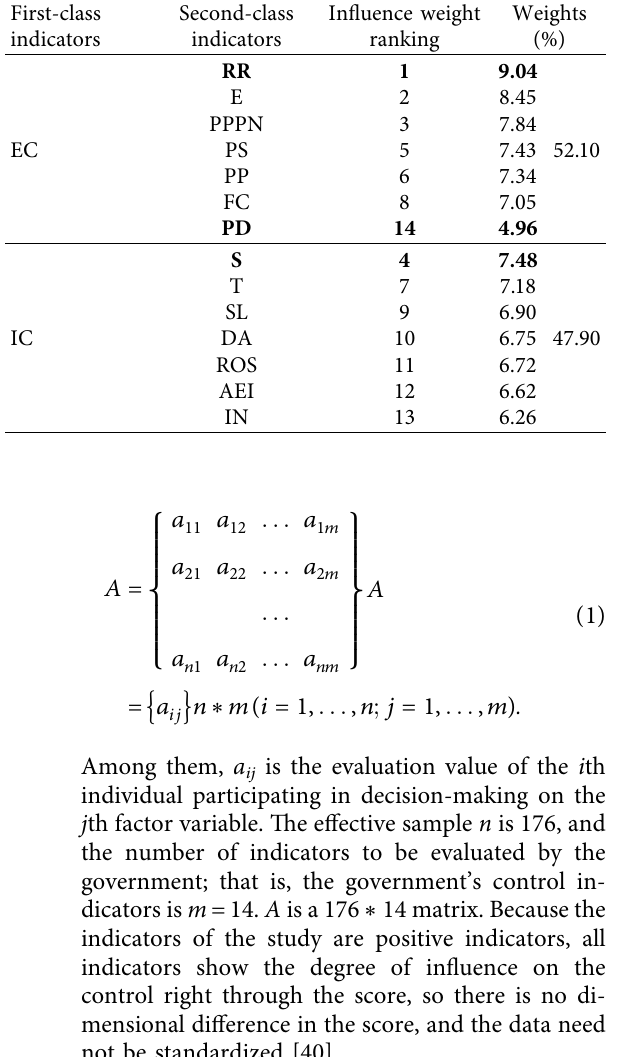
Table 3: Influence weight of control